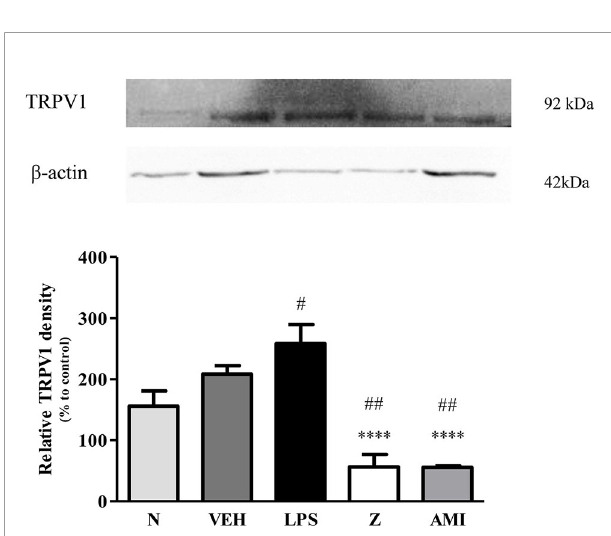
FIGURE 11 | Representative western blots of NMDA NR2B receptor from brain samples of naïve, sham, vehicle and zerumbone-treated groups. Data presented as mean ± SEM (n = 4), which were normalized to b -actin. + p < 0.05 as compared to naïve, ## p < 0.01 as compared to sham group and ^ p < 0.05 as compared to vehicle. NAI (Naïve); SHM (Sham); VEH (Vehicle, 10 mL/kg); Z (Zerumbone, 10 mg/kg).